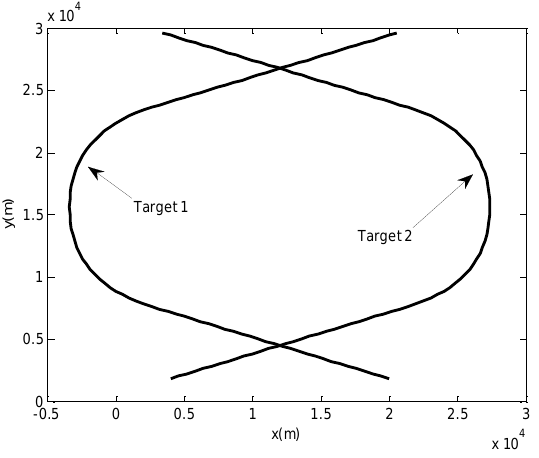
Figure 6. The trajectories of two cross-maneuvering targets.